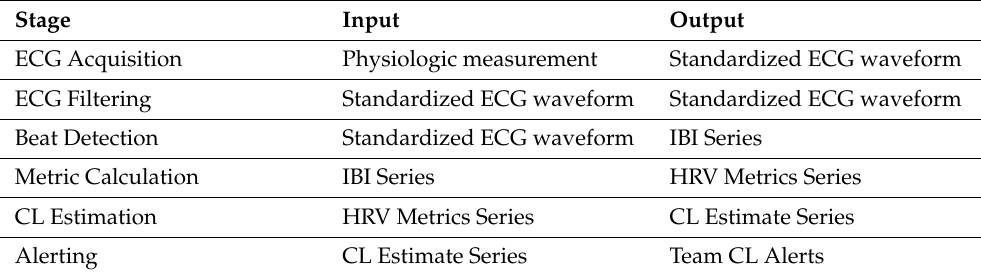
Table 1. Processing Pipeline Stages, Inputs, and